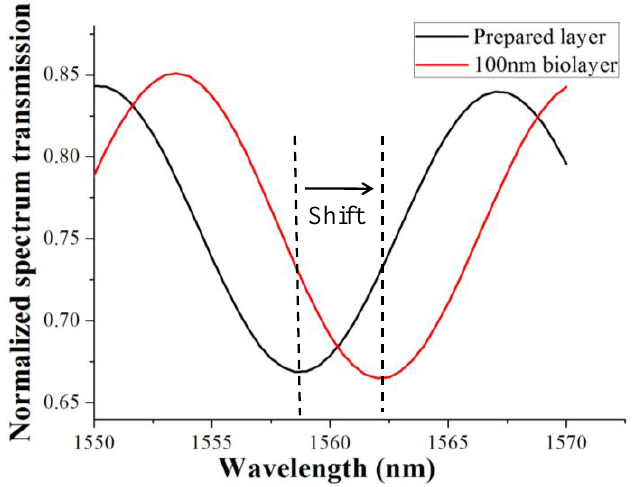
Figure 8. The transmission spectrum fringe redshift. The black curve indicated the transmission spectrum under a bio-test preparation layer with refractive index 1.33 and thickness 100 nm. After a target biolayer with refractive index 1.33 and thickness 100 nm was bonded above the preparation layer, the redshift 3.5 nm was represented by the red curve.